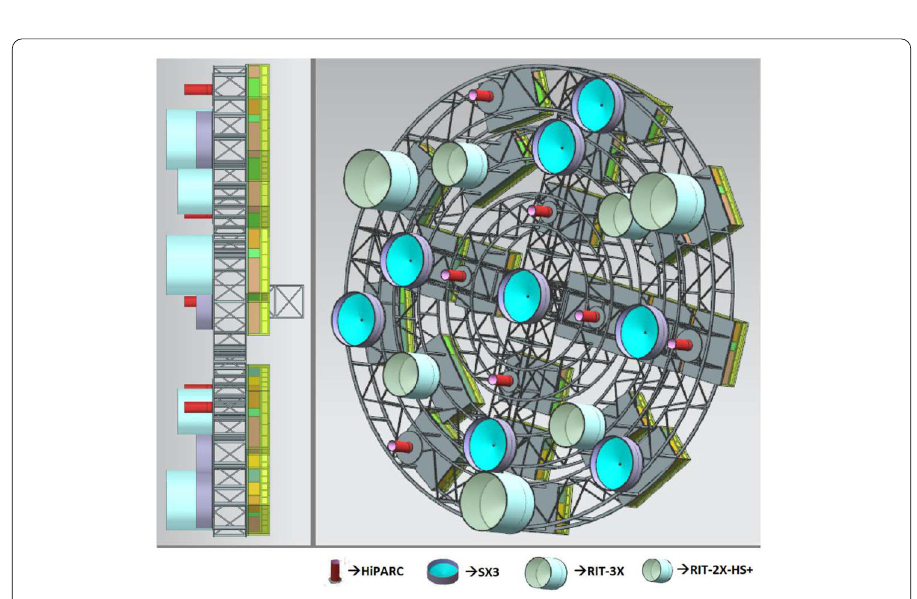
Figure 4 CAD design of gridded cluster plate including German electric thrusters with redundant PPUs for each thruster at the